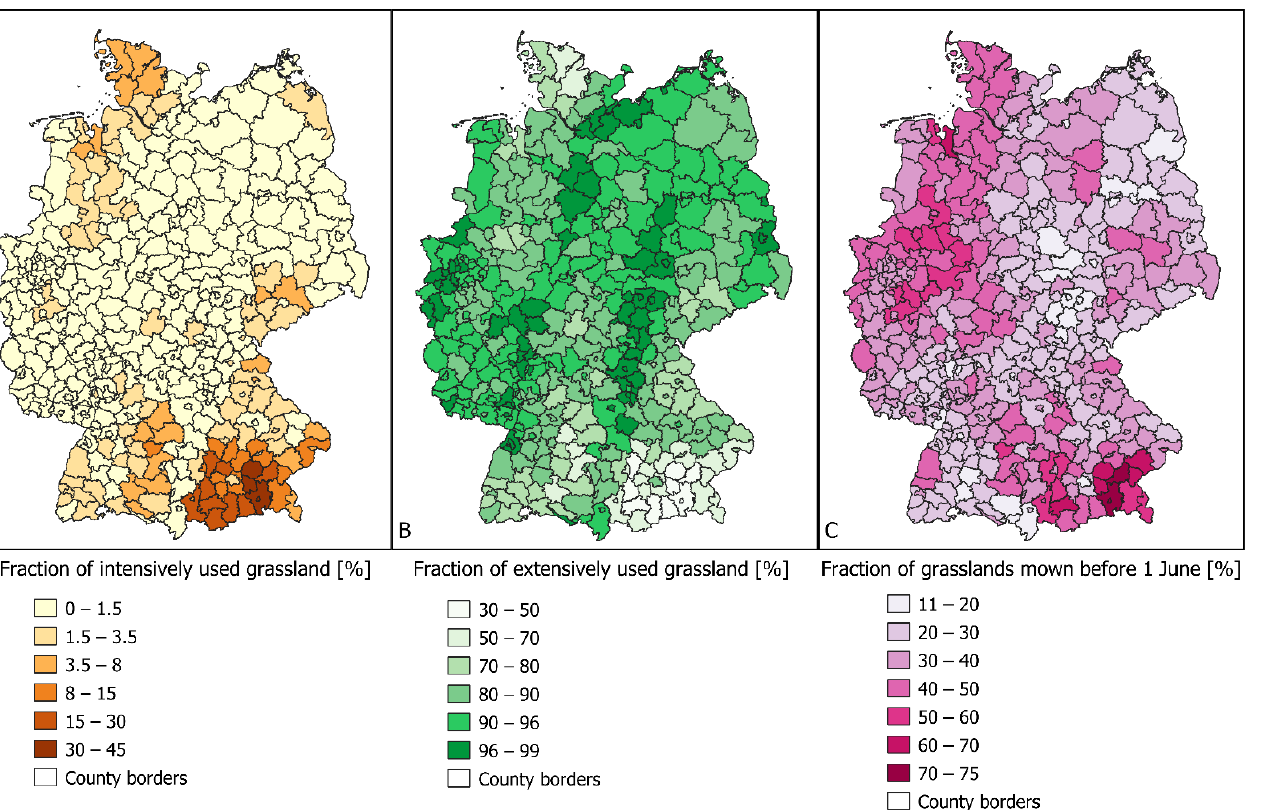
Figure 14. Quality information for the S2 dataset 2019 represented by the number of large gaps ( A ), and uncertainty information of the mowing frequency, estimated from the gradient and data availability of the detected mowing events ( B ) for the focus region (Ammer region) and a zoom region indicated on the map.